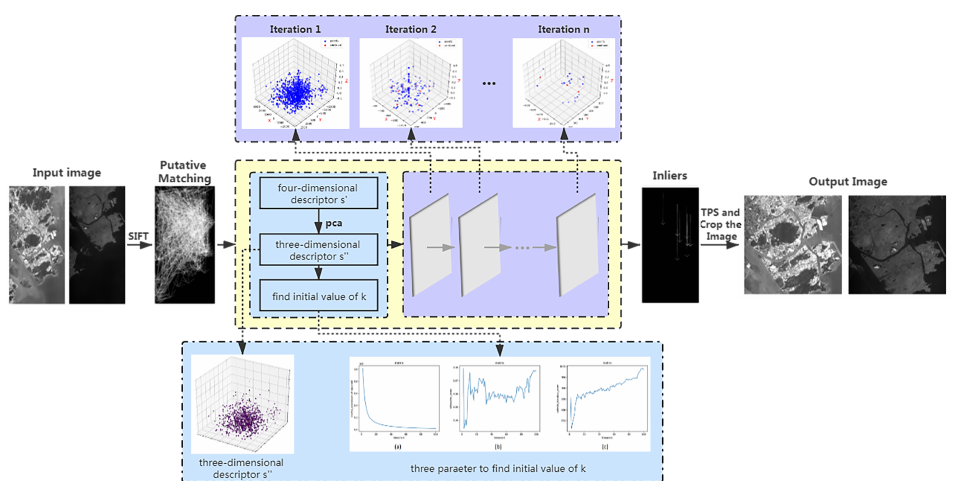
Figure 2. The proposed adaptive interband registration framework based on adaptive iterative clustering. The main body is illustrated in the second row. We get putative matching from the input image pair through the scale-invariant feature transform (SIFT) algorithm. Then, we enter the yellow flow diagram, which is Algorithm 1. It contains two parts: preprocessing (blue diagram) and adaptive iterative clustering (purple diagram). After the iterative clustering reaches convergence, the cluster with the largest number of points is obtained, which is the inliers. From the inliers, the thin-plate spline (TPS) algorithm is used and the image is cropped to obtain the output image pair. Among them, the first row is a visual image to supplement the iterative clustering process; the third row is a visual image to supplement the preprocessing process.